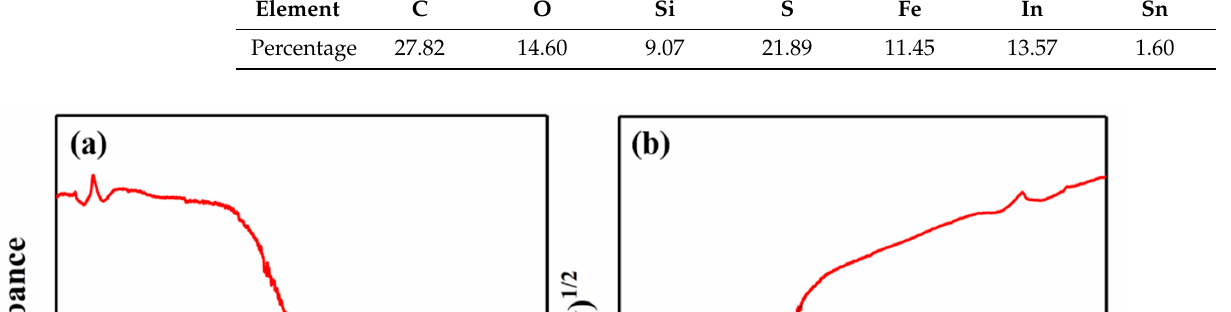
Figure 7. EDX result of iron pyrite film. Table 2. Atomic percentage of iron pyrite film.